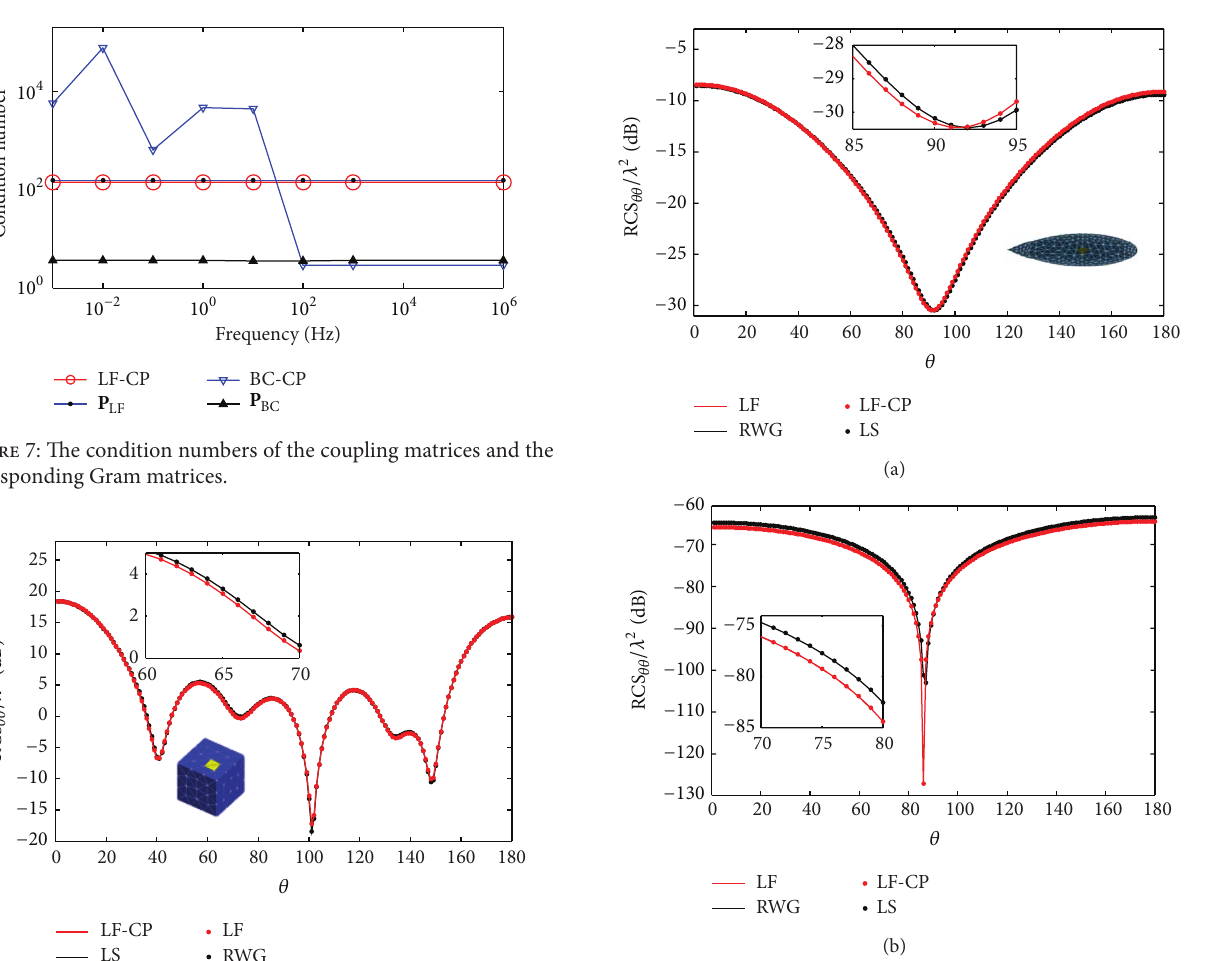
and 216 RWGs. In order to implement BC-CP, (216 × 6 = 1296)